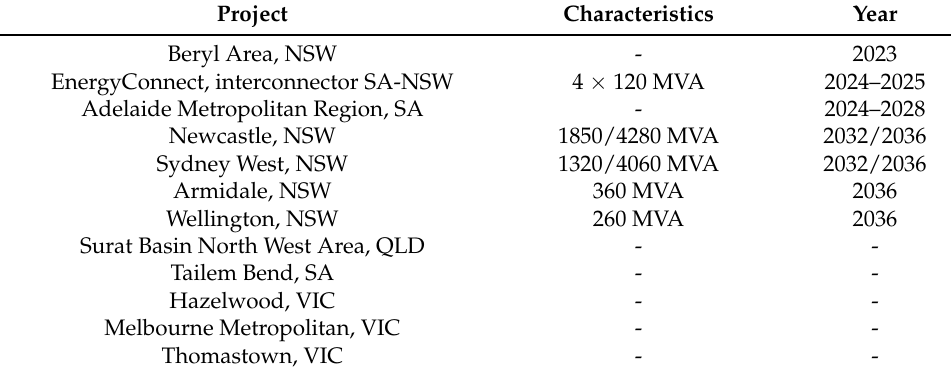
Table 3. Indicative synchronous condensers projects in Australia [48,52,54,55]. Project